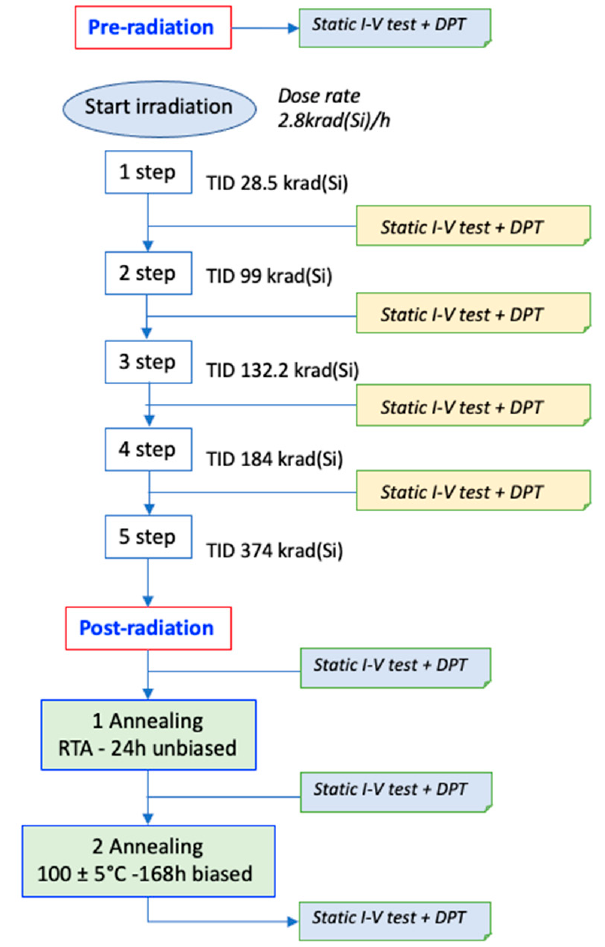
Figure 2. A schematic diagram of the experimental procedure of the gamma test campaign.